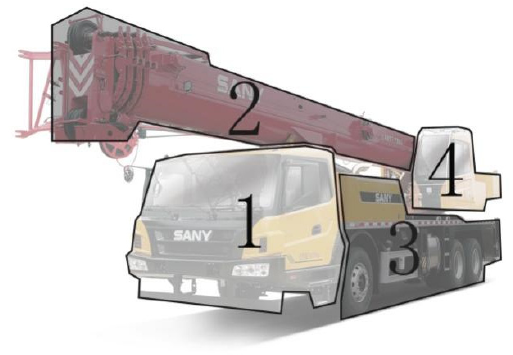
Figure 7. Users’ visual trace when observing the truck crane.